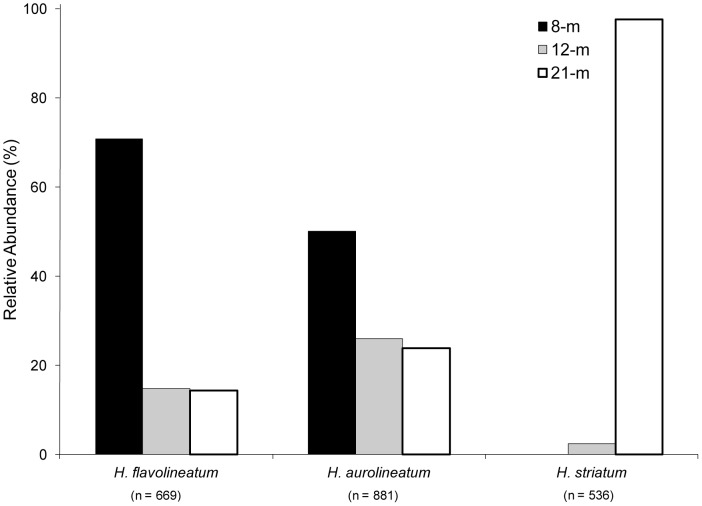
Relative abundance of species of Haemulon at each site, based on specimen totals from collections of new settlers on ARs (pooling all experimental trials).